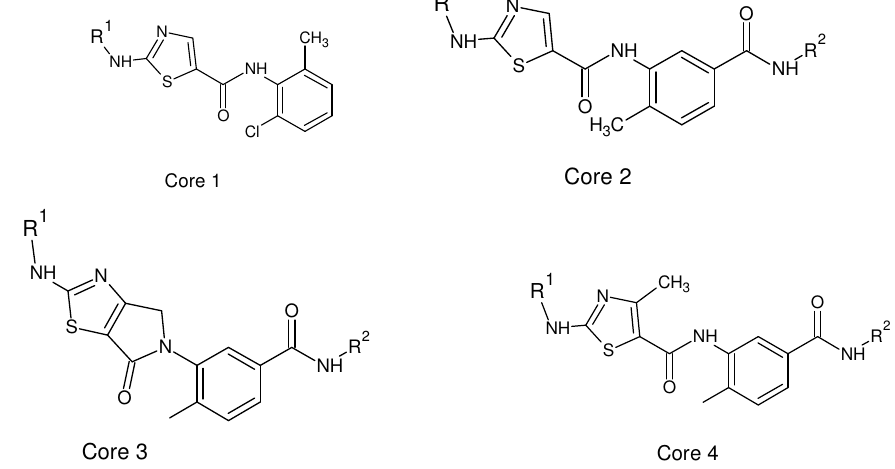
Figure 1. Core molecules of MAP kinase